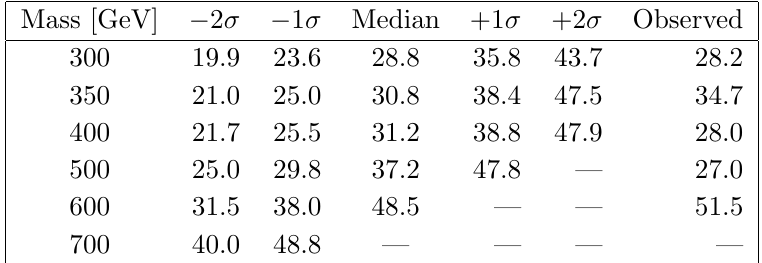
Table 4 . Expected and observed 95% CL upper limits on tan (cid:12) as a function of m A in the light benchmark scenario. Since theoretical predictions for tan (cid:12) > 60 are not reliable, entries for which tan (cid:12) would exceed this value are indicated by |.